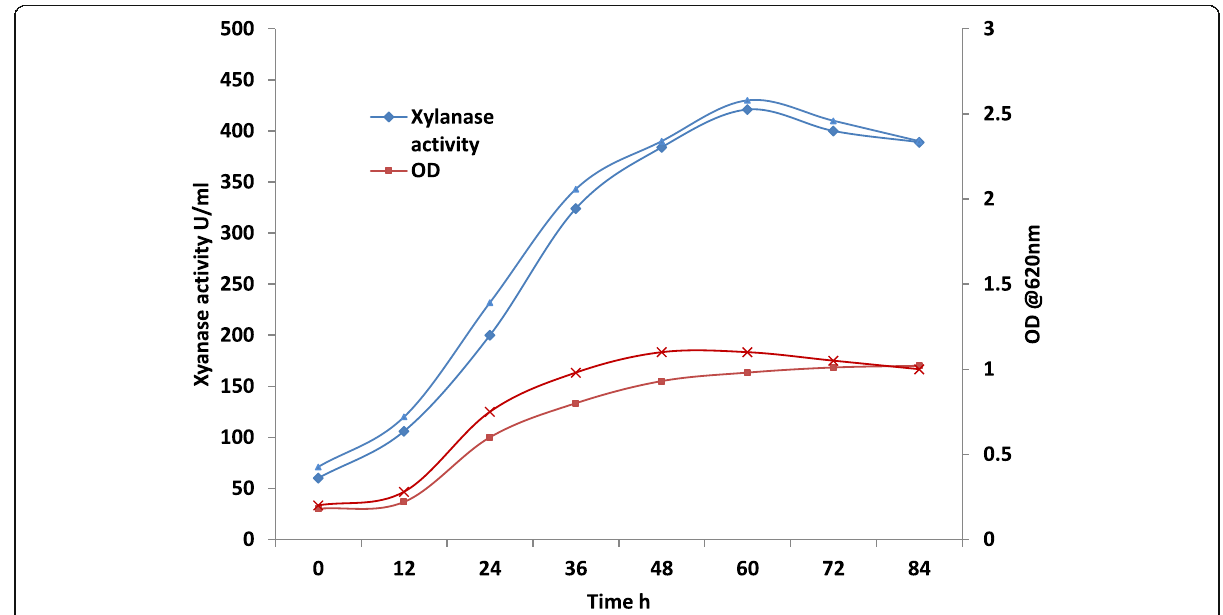
Fig. 7 Xylanase production and growth obtained in stirred tank